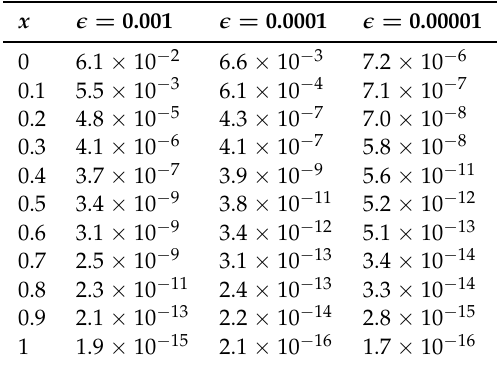
Table 3. The error for (cid:101) = 0.0001, 0.00001, and 0.000001.